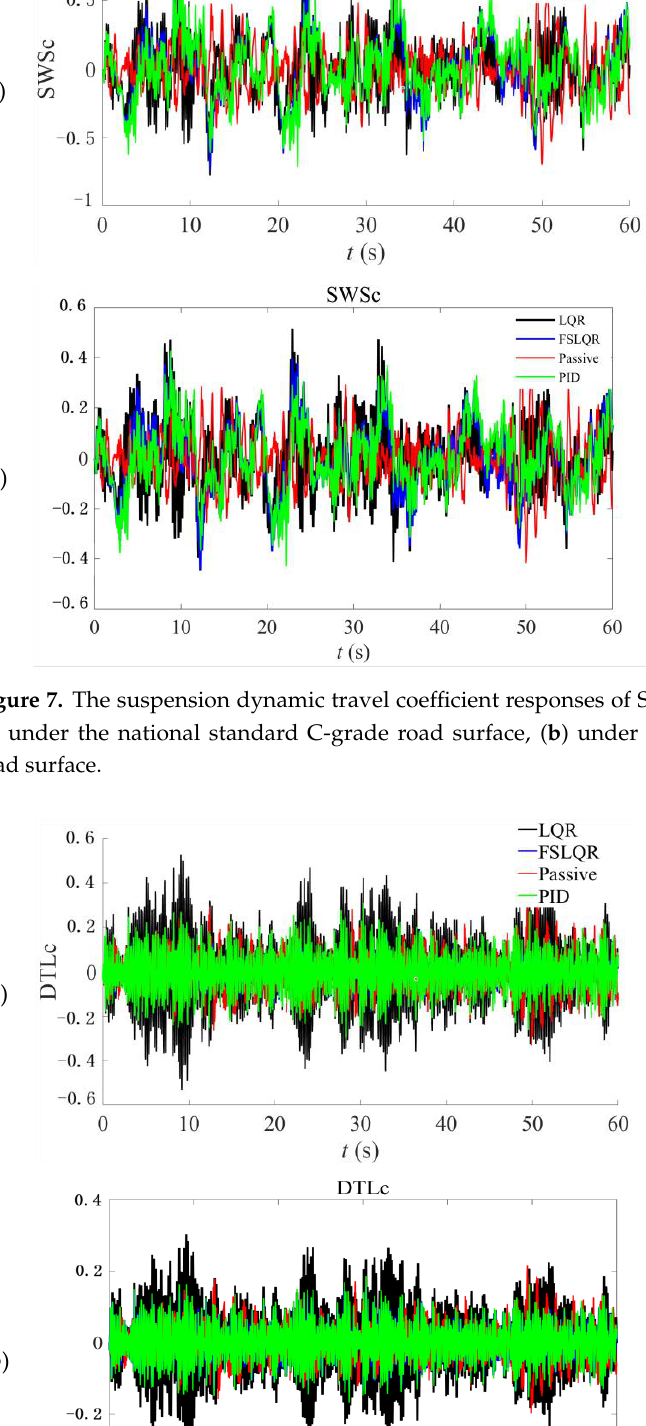
( a ) ( b ) Figure 9. The sprung mass ’ s acceleration responses under random excitation, ( a ) under the national standard C-grade road surface, ( b ) under the national standard B-grade road surface.